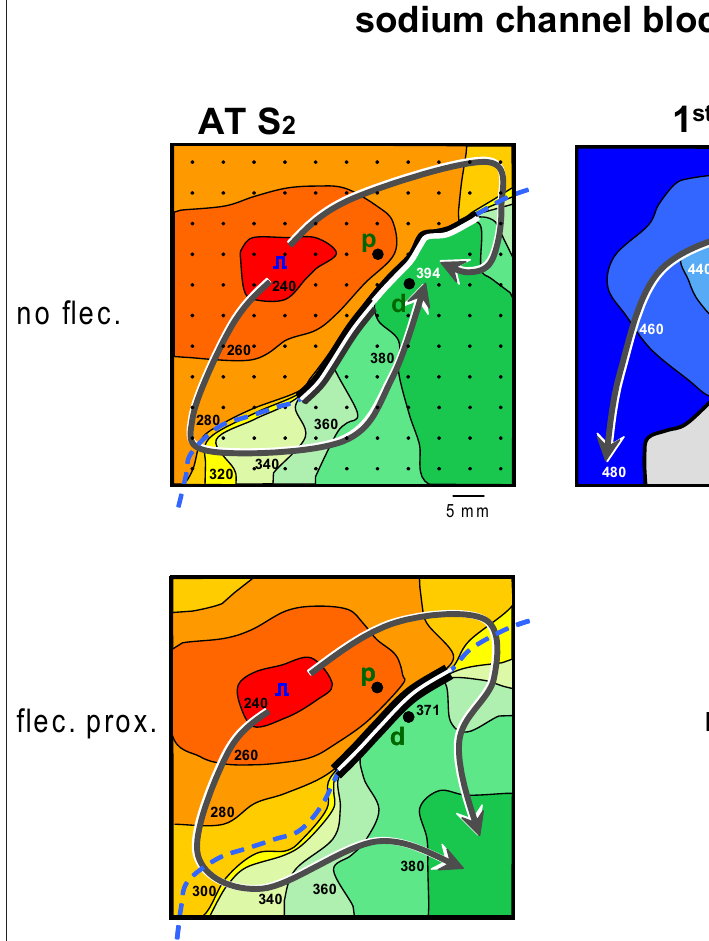
of the FF and failure of induction of VF. The increase of FF was reached by two mechanisms: first the proximal line of block was shortened because the activation front reached the line of block later. This also led to an earlier activation of the tissue distal to the line of block. Second because proximal S2 repolarization was delayed. Symbols as in Figure 2